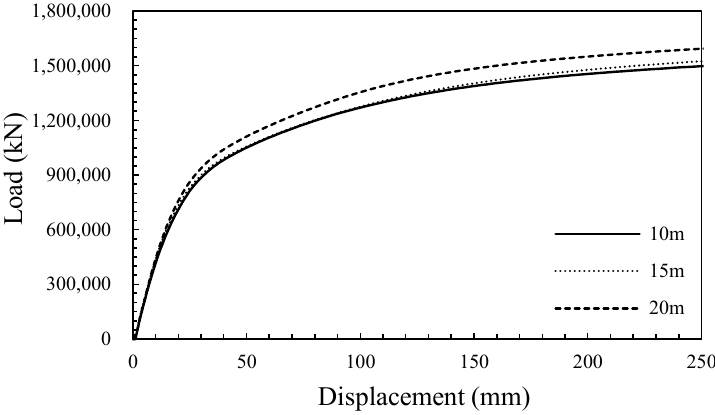
Figure 12. Load–horizontal displacement curve with joint spacing.